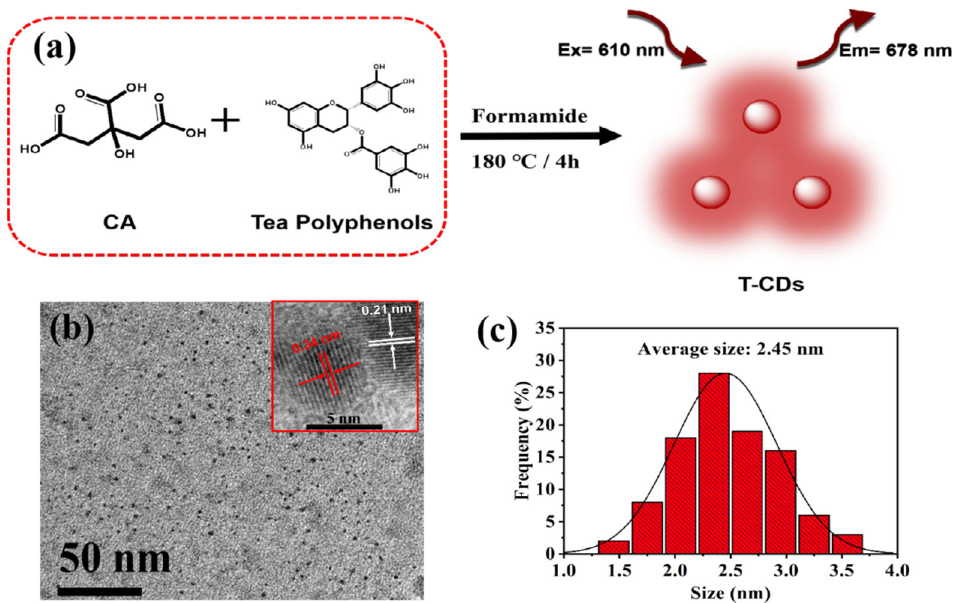
Figure 1. ( a ) Schematic diagram of the synthesis procedures and optical properties of T − CDs; ( b ) a typical TEM image (inset: HRTEM image); and ( c ) the corresponding particle size distribution histogram of T − CDs.